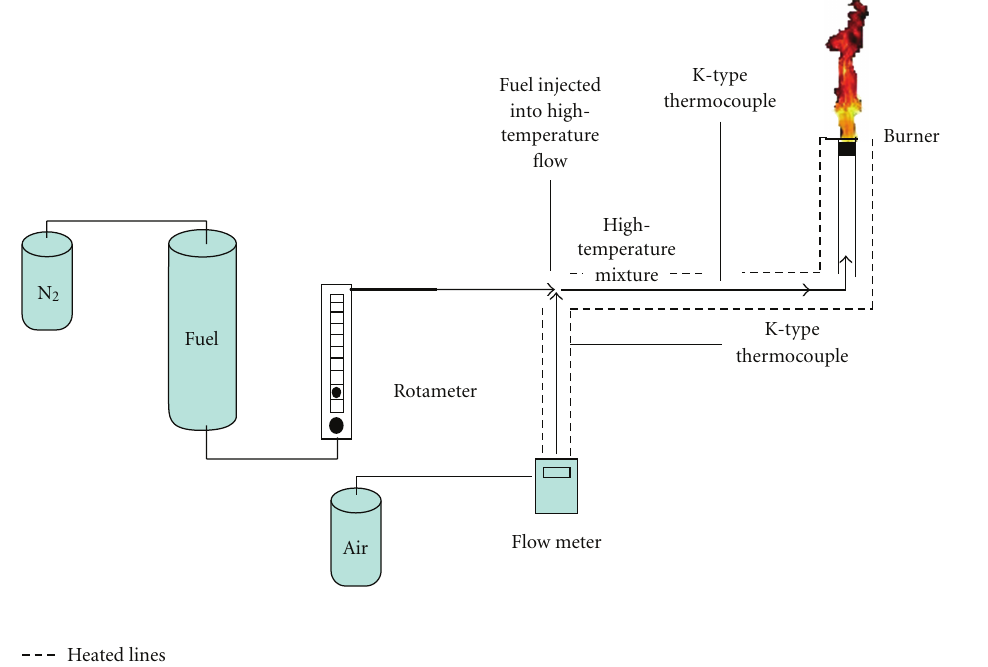
Figure 1: Schematic diagram of the experimental setup.